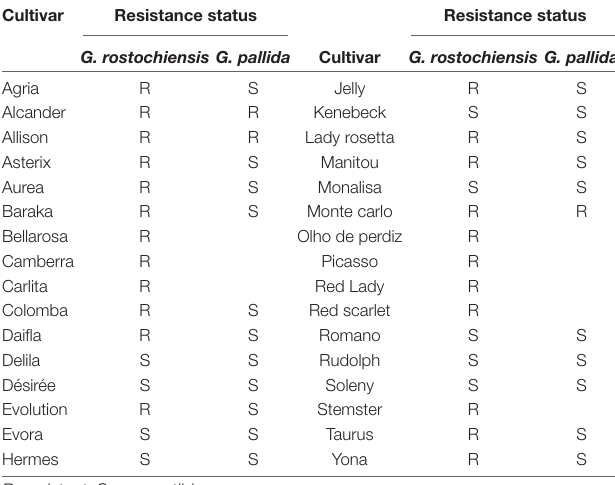
TABLE 1 | Samples tested for Globodera rostochiensis and Globodera pallida in Portuguese regions between 2013 and 2019 (absolute values and %). Region Positive detections Negative detections